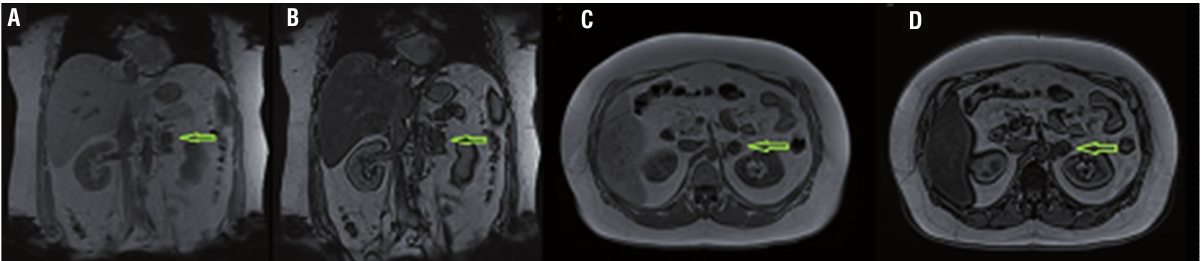
figure 2 - Magnetic resonance images (EcO Gradient sequences GRE) T1w1 inside and outside of phase (A and B) and in T2 with and without fat suppression (c and D); they show sparse areas of signal loss corresponding to lipomatous foci.